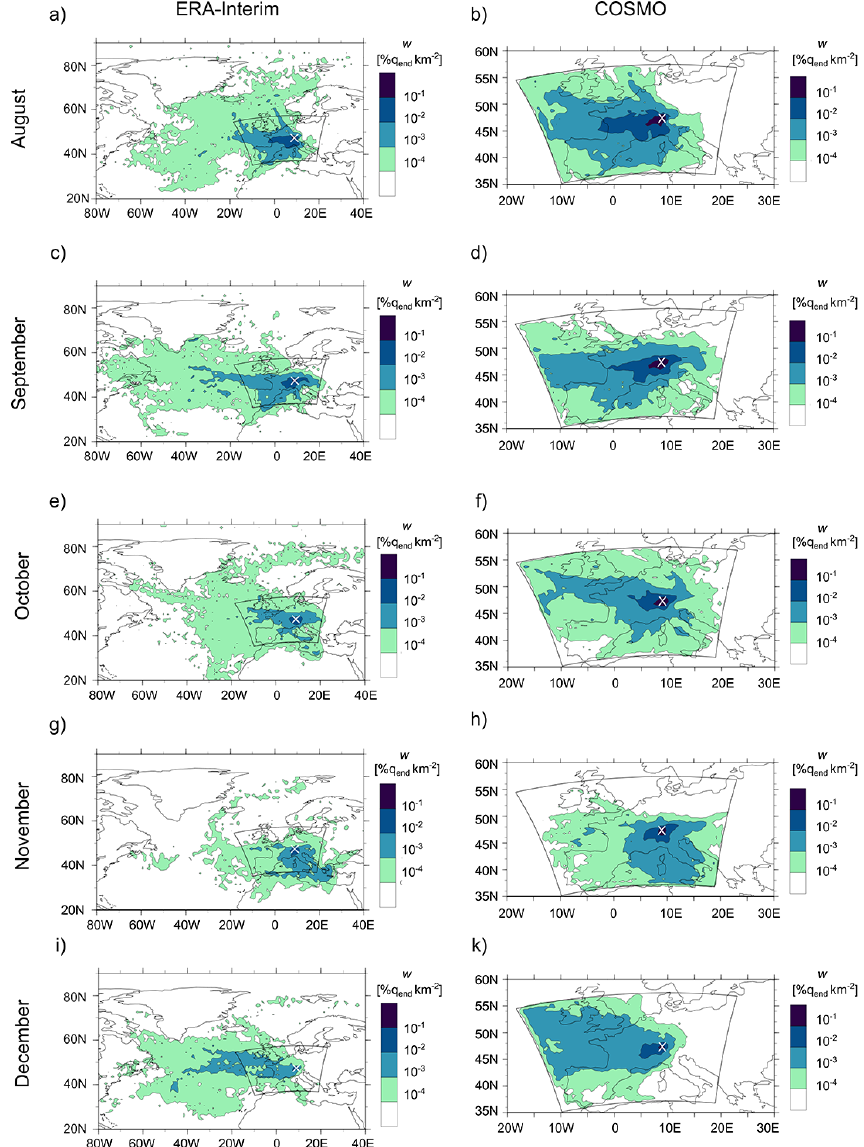
Fig. 3. Monthly average moisture sources between August and December 2011 identified using ERA-Interim (left) and COSMO analyses (right). Colour coding indicates percental contributions to the final specific humidity per km 2 ( w ). The integral over the entire moisture source region sums up to 100% of the explained moisture at the Rietholzbach site. The white cross indicates the location of the isotope measurement site Rietholzbach. The COSMO domain is indicated by a curved black